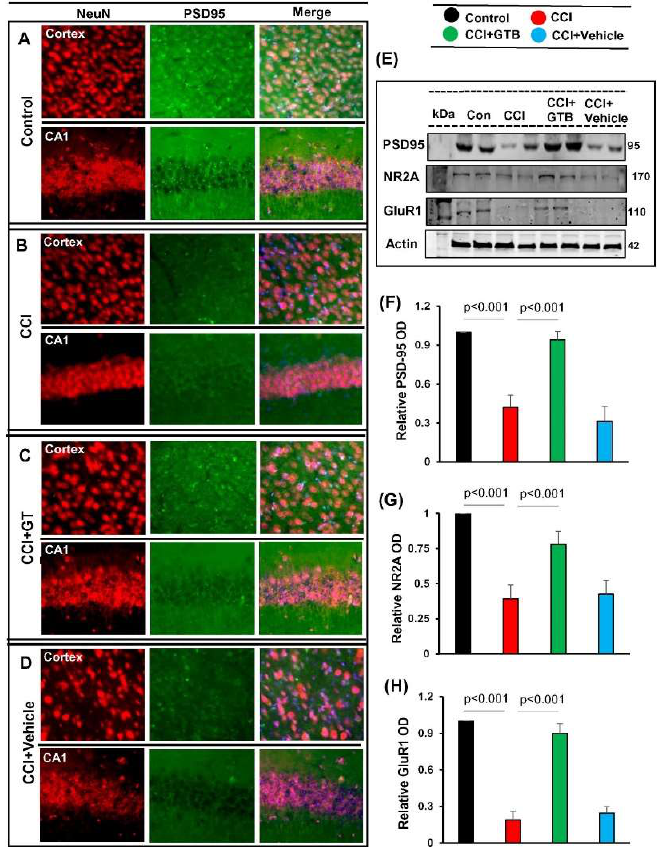
Figure 4. Restoration of PSD-95, NR2A and GluR1 in the hippocampus of TBI mice by oral administration of GTB. TBI was induced in mice by CCI injury and after 24 h of injury, mice were treated with 50 mg/kg/day of GTB via oral gavage. Twenty-one days after CCI injury, brain sections were double-labeled for NeuN and PSD-95 (( A ), control; ( B ), CCI; ( C ), CCI + GTB; ( D ), CCI + Vehicle). Results represent analysis of one section of each of six mice per group. Hippocampal tissue extracts from all groups of mice (n = 4 per group) were immunoblotted for PSD-95, NR2A and GluR1 ( E ). Actin was run as a loading control. Bands were scanned, and values (Iba1/Actin, ( F ); NR2A/Actin, ( G ); GluR1/Actin, ( H )) presented as relative to control. Data are expressed as mean ± SD. Statistical analyses were performed with one-way